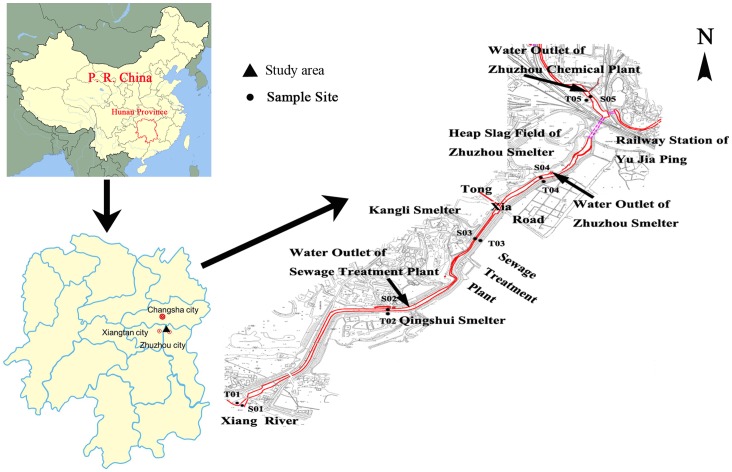
Study area and geographical location of ten stations in Xiawangang River.